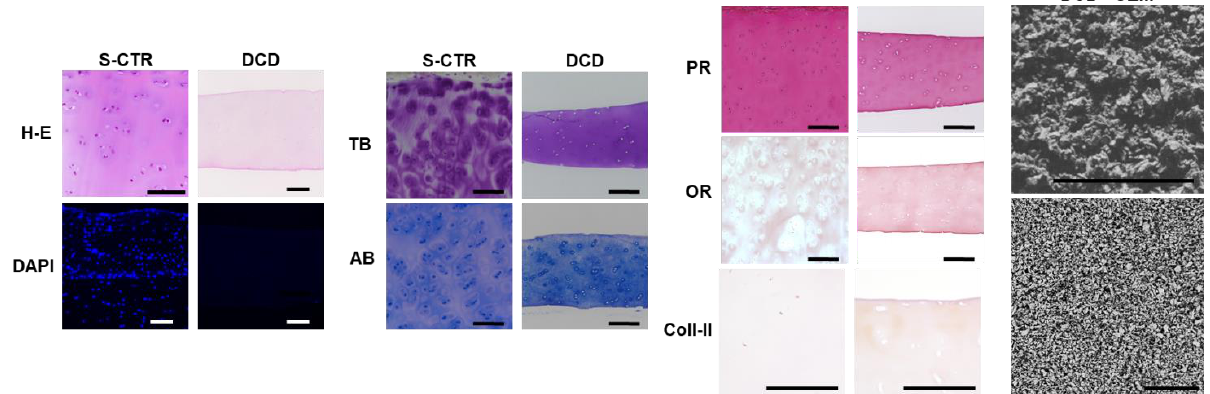
Figure 3. Histological analysis of S-CTR and decellularized cartilage disks (DCD) with H-E, DAPI, histochemistry for TB, AB, PR and OR, and immunohistochemistry for Col-II. DCD - SEM: DCD analyzed with scanning electron microscopy at two different magnifications. Scale bars: 200 µm.